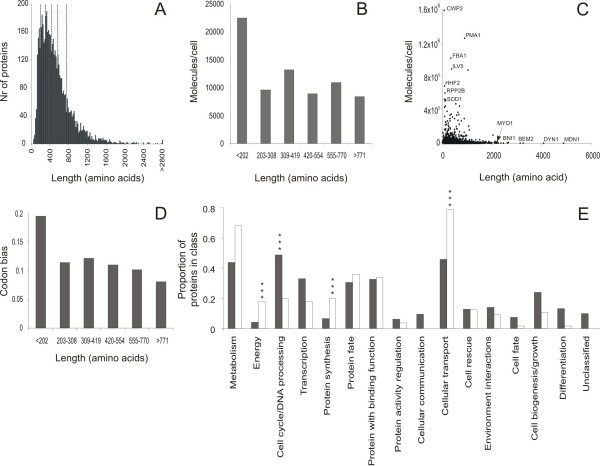
Smaller proteins are more highly expressed than larger proteins. Comparing S. cerevisiae protein expression and protein size data. A) Size distribution of re-annotated yeast protein lengths (average of 501 amino acids). Dashed lines indicate limits for size categories. B) Experimentally determined mean protein abundance (molecules/cell) in different (bins containing equal numbers of proteins) size categories during exponential growth [24]. C) Comparing protein abundance (molecules/cell) and protein length for individual proteins. Outliers are indicated. D) Mean codon bias in different (bins containing equal numbers of proteins) size categories during exponential growth. E) Proportion of both highly expressed (>12,273 molecules/cell) and (length>771) large proteins (empty bars) as compared to large proteins in general (filled bars) in different functional classes.